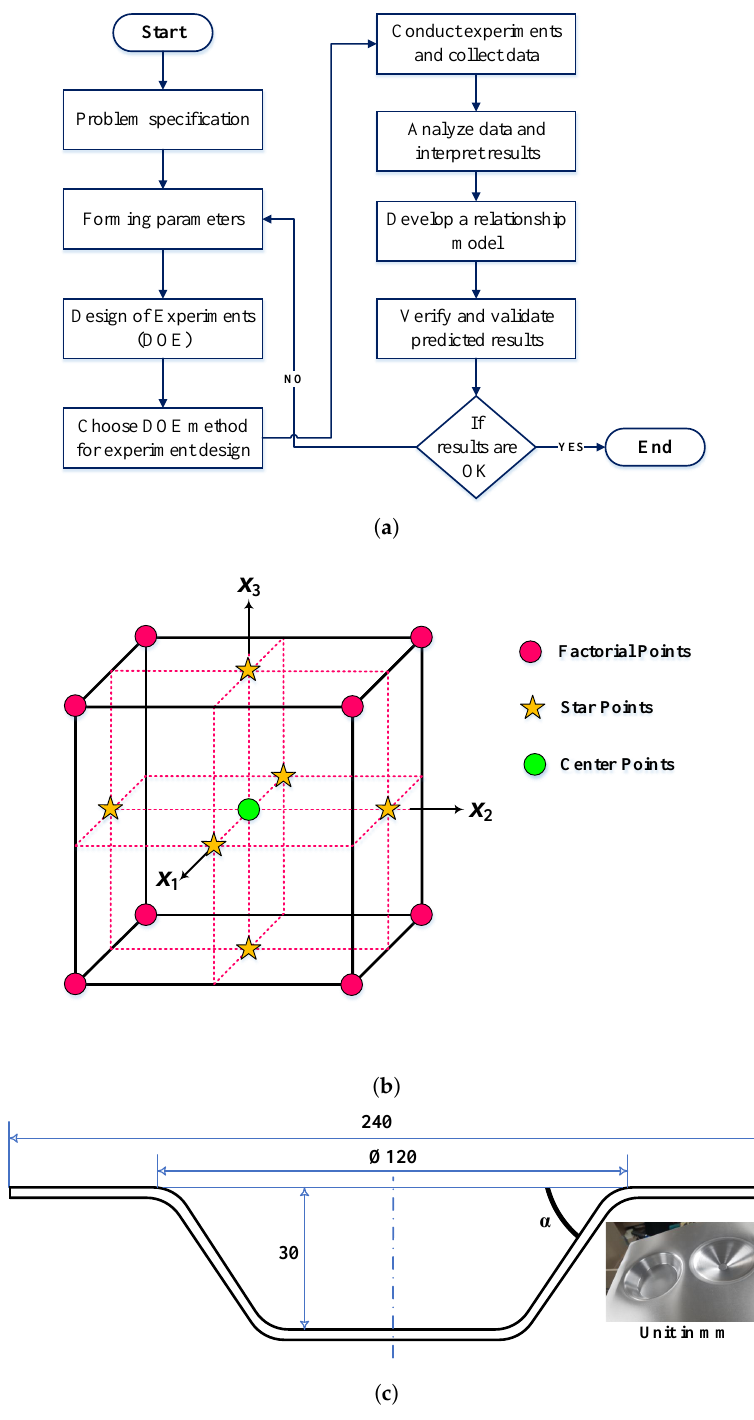
Figure 7. ( a ) Flow chart of experimental design process; ( b ) CCF design; ( c ) truncated conical